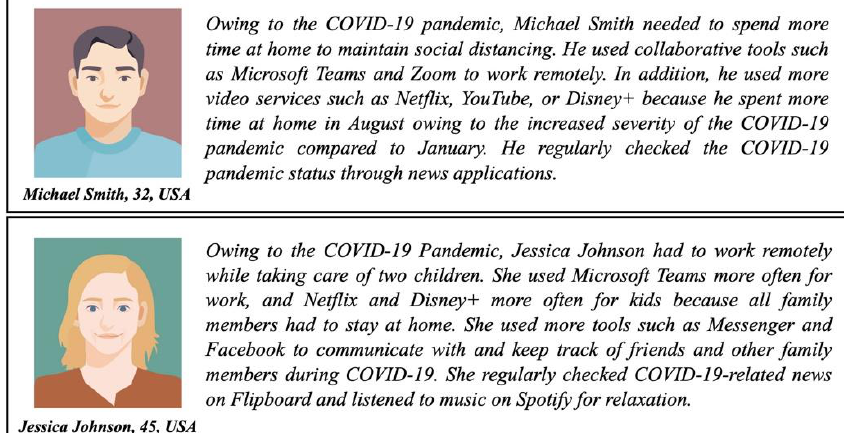
Figure 5. Graph describing top 100 applications list between January and August 2020.